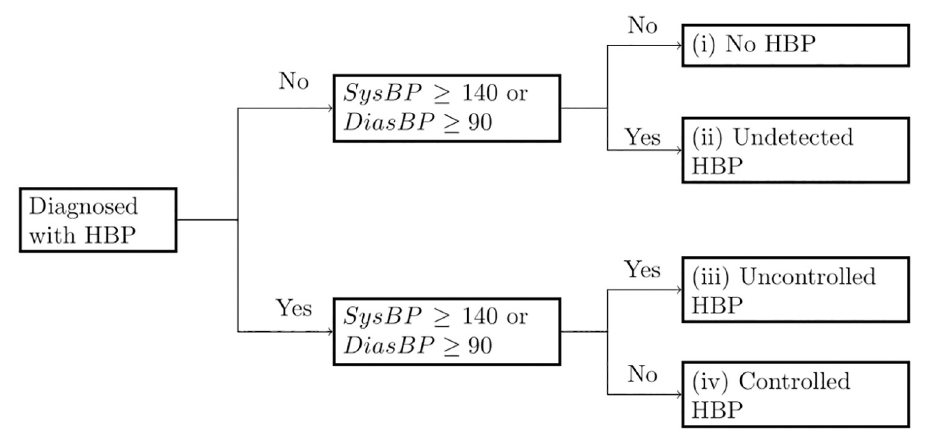
Fig 1. Definition of high blood pressure classification groups. Notes : Diagnosis of HBP by a physician correspond to the self-response of individuals. SysBP and DiasBP correspond to the blood pressure measurement by a nurse at the time of the